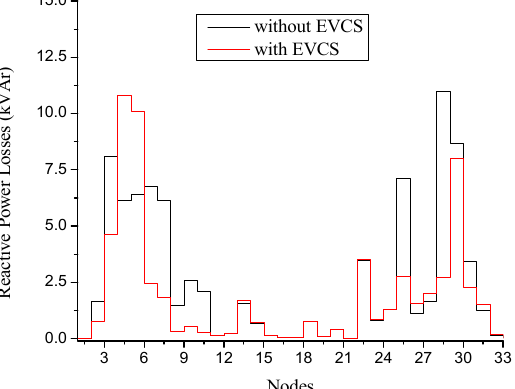
Figure 9. Reactive power losses with and without the integration of EVCS.